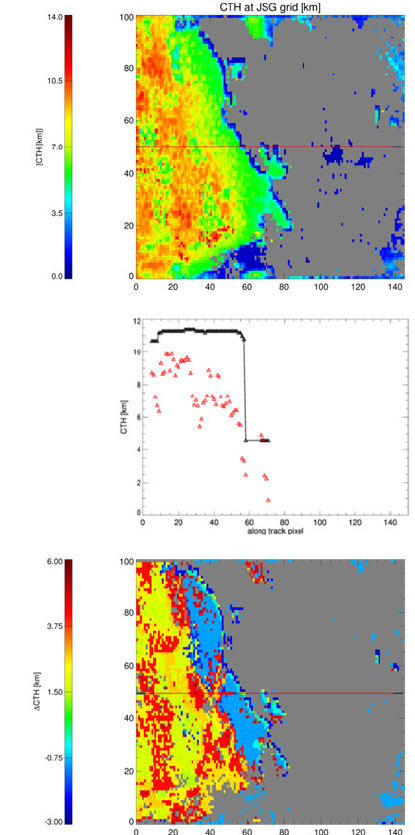
Fig. 2 Cloud top height from MSI with the ATLID track indicated in red (upper panel), MSI CTH (red symbols) and ATLID CTH (black symbols) along track (middle panel), and synergistic CTH difference (lower panel) for the COSMO